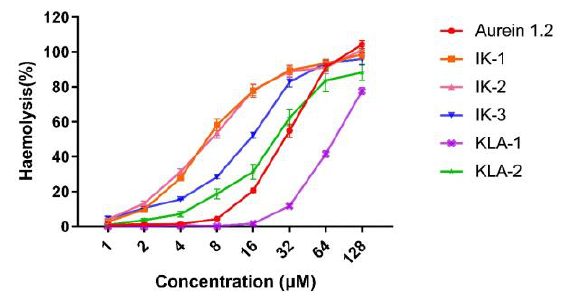
Figure 9. Hemolytic activity of aurein 1.2 and its analogs against horse blood cells. The percentage of hemolysis was calculated using 1% TritonX-100 as the positive control. Phosphate-buffered saline (PBS) was applied as the negative control. The error bars represent the SEM (standard error of the mean) ( n = 9).